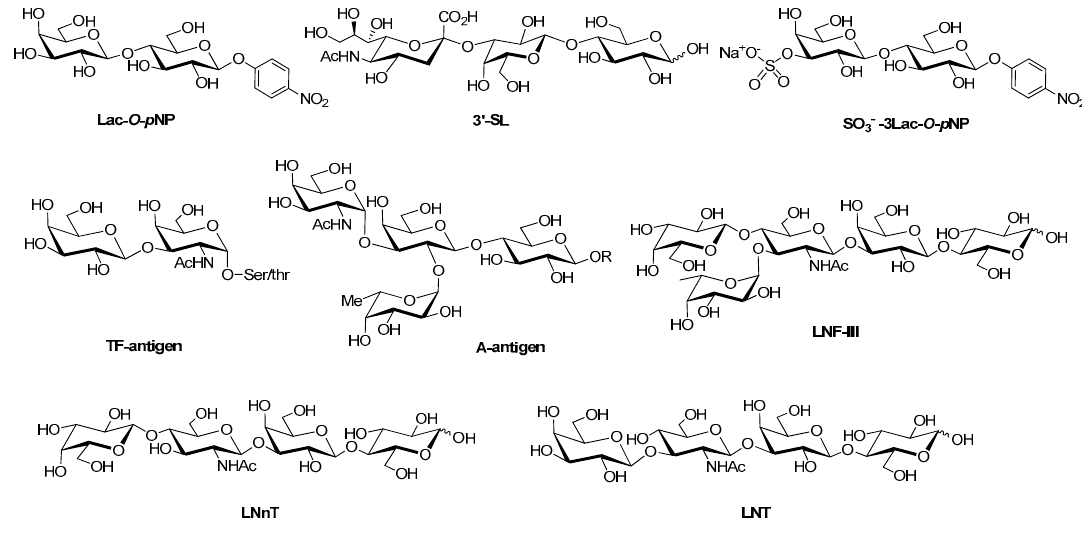
Figure 6. Representative structures of galectin ligands. Table 1. Amino acids of the CRDs of six galectins directly interacting with lactose residues are shown in red, and amino acids that interact with lactose via water-mediated hydrogen bonds are shown in blue. Comparison with galectin-1 (PDB-1GZW), galectin-2 (PDB-1HLC), galectin-3 (PDB-1KJL), galectin-4 (PDB-1X50), galectin-7 (PDB-4GAL), and galectin-8 (PDB 3AP9). Amino acids letter codes are indicated in parentheses for Gal-3 [26].